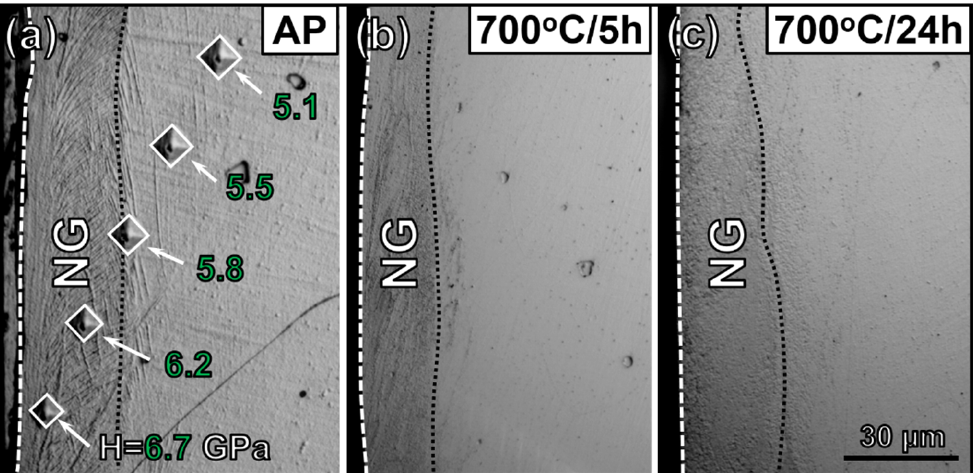
Figure 1. Optical microscopy images of ( a ) as-processed (AP) and annealed gradient IN718 alloy at 700 °C for ( b ) 5 h and ( c ) 24 h. The topmost nanograined (NG) regions are labeled by dotted lines. Vickers indentation and corresponding hardness values (in GPa) are labeled.